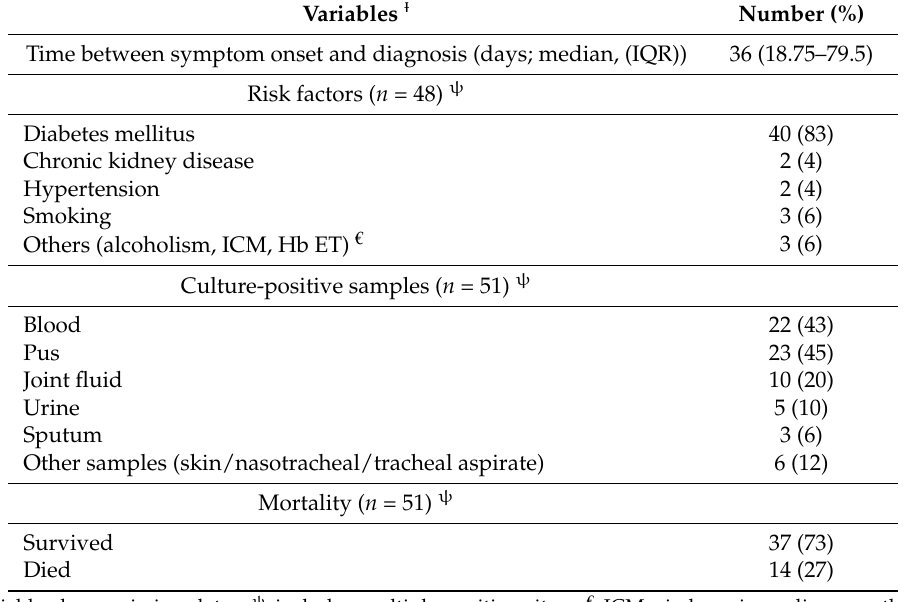
Table 3. Prehospital and laboratory characteristics and clinical outcome of culture-confirmed cases. Variables Number (%) Time between symptom onset and diagnosis (days; median,